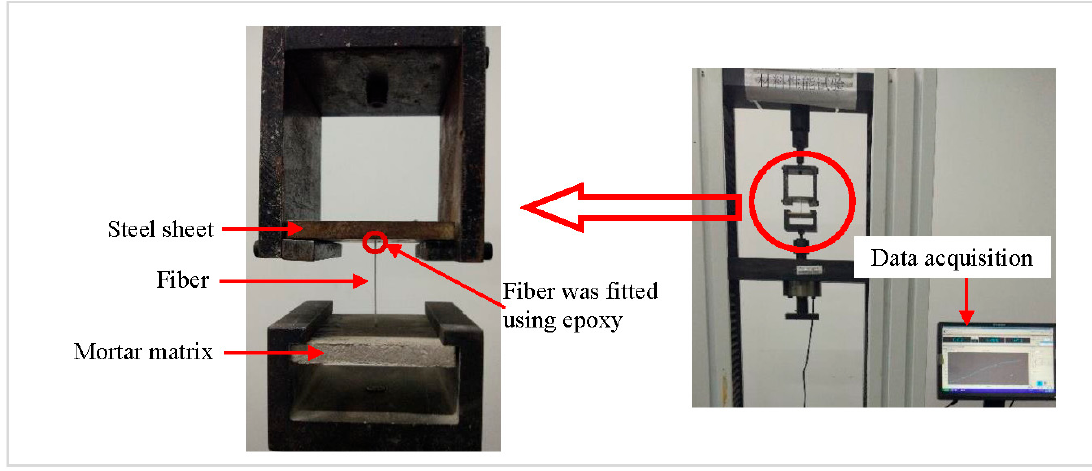
Figure 4. The pull-out test setup.